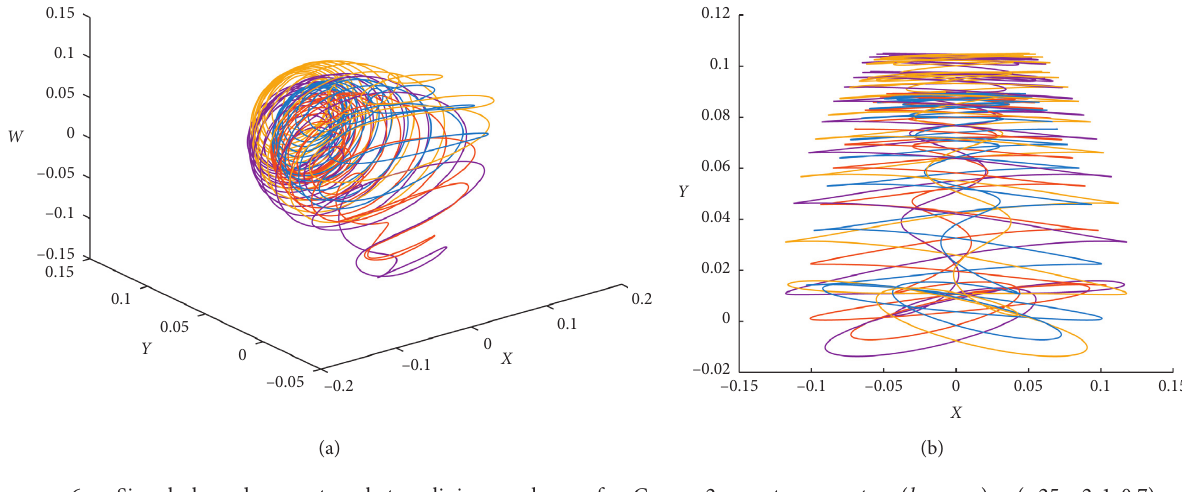
Figure 7: Phase portraits of Case 2 system: set ( h,a,e, g ) � (− 25 , − 2 , 1 , 0 . 7 ) , (a) ( x ,y , z , w ) � (− 0 . 0918 , 0 . 08 , − 0 . 00469 , − 0 . 00290 ) . (b) ( x 0 0 0 0 –2–1.5–1–0.500.511.52